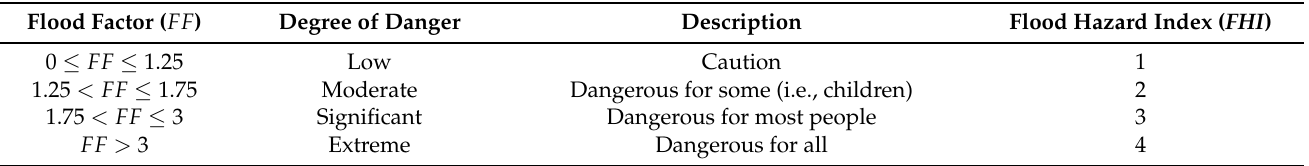
Table 4. Flood hazard